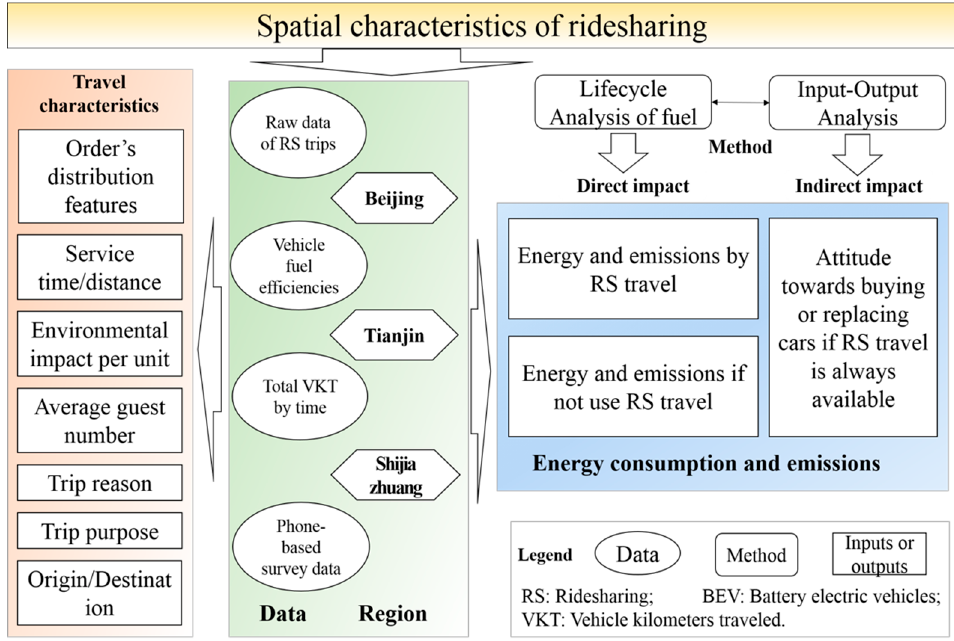
Figure 1. General framework of this research.